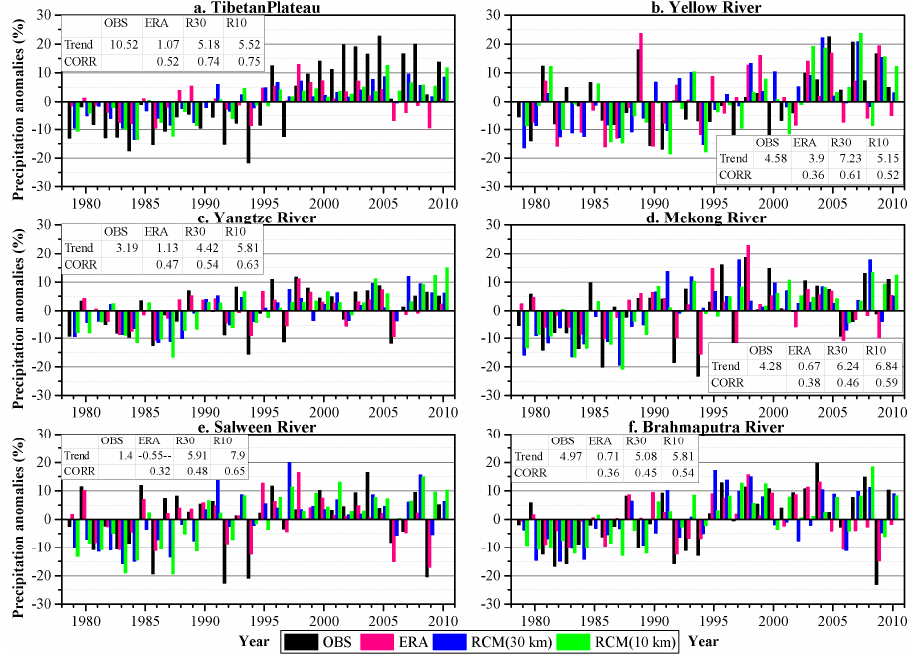
Figure 6. Same as Figure 5, but for precipitation (the unit of trend is %/decade). The whole Tibetan Plateau (TP) ( a ) and five river basins ( b – f ) for the period 1980 − 2010. Plateau (TP) ( a ) and five river basins ( b – f ) for the period 1980 −